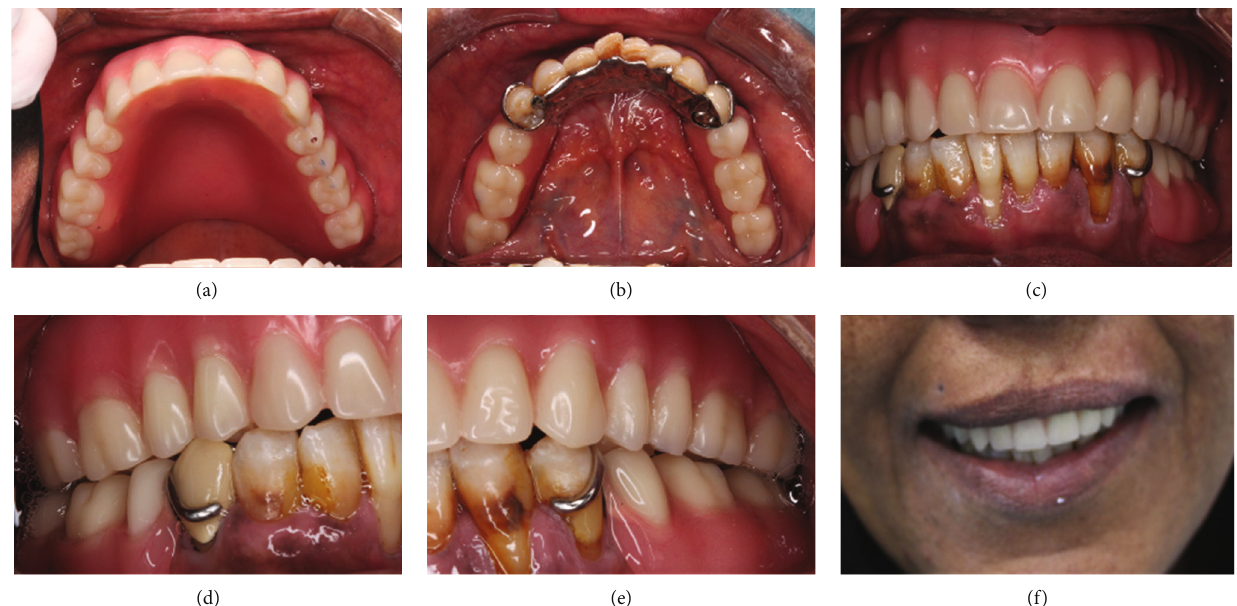
Figure 26: (a) – (f) Final prostheses upper telescopic complete denture and lower chrome cobalt removable partial